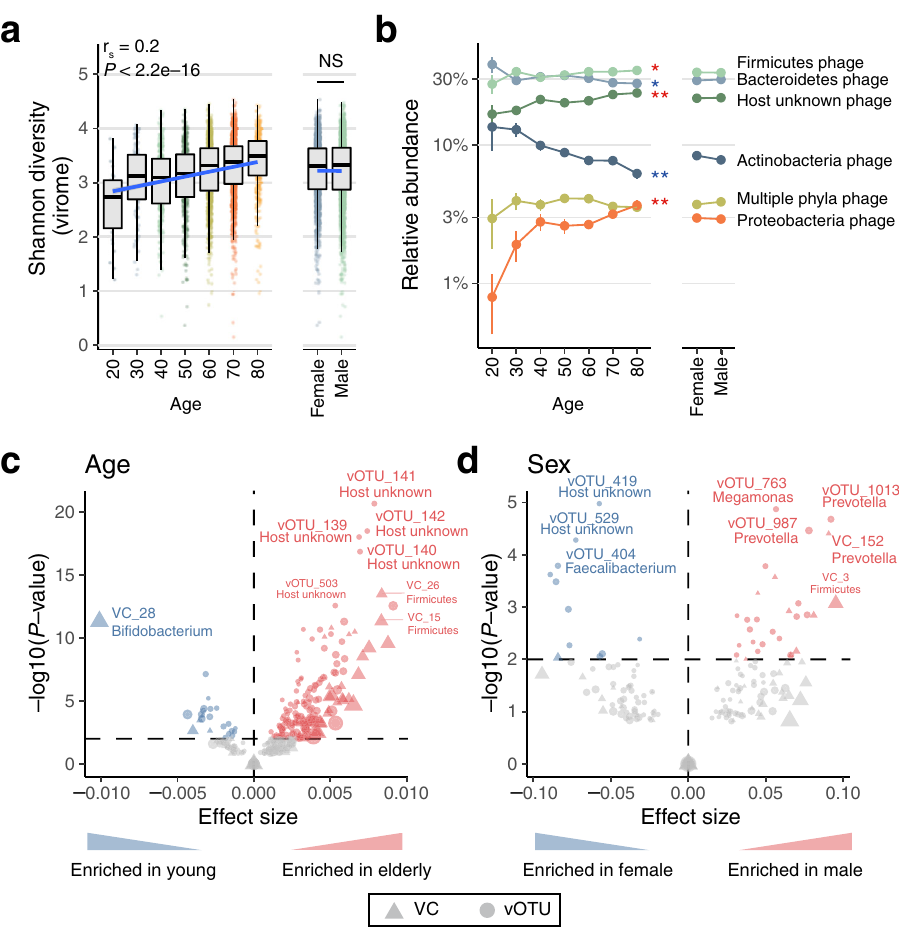
Fig. 4 | Age- and sex-related changes in the human gut virome. a Correlation between age/sex and the Shannon index of the virome. Individuals younger than 20years( n =2)andolderthan80years( n =6)wereexcludedfromtheplotdueto the low numbers of individuals. Spearman correlation and its statistical sig- ni fi cant was calculated using the cor.test function in R (two-sided). b Average relative abundance of phages grouped according to the phylum-level taxonomy of host bacterial species. Each plot represents the average (mean) relative abundance of all the phages predicted to infect the phylum at each age. Red and blue asterisks show signi fi cant positive and negative correlations, respectively